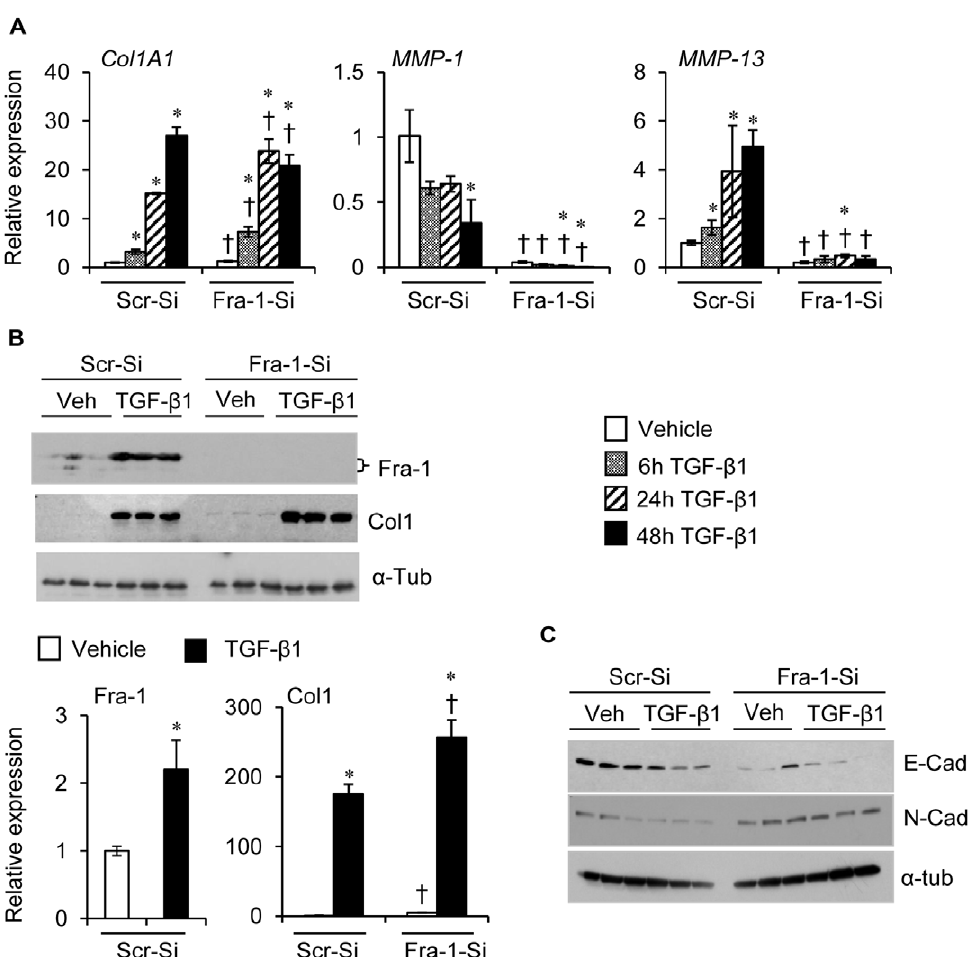
Figure 9. The effects of Fra-1 knockdown on TGF- b 1-induced fibrotic and anti-fibrotic, and mesenchymal marker gene expression in AECs. Cells were treated with vehicle or TGF- b 1 (5 ng/ml) for different time points, and harvested for RNA and protein isolation. A: Col1A1 , MMP-1 and MMP-13 expression analyzed by qRT-PCR. B: Fra-1, Col1 and a -tubulin protein expression as analyzed by immunoblot in AECs cells treated with vehicle or TGF- b 1 for 24 hours. C: E-cad, N-Cad, and a -tubulin detected by immunoblot in AECs treated with vehicle or TGF- b 1 for 24 hours. Results are mean 6 SD, representative of 2 separate experiments performed in triplicate per group. P , 0.05, PBS vs TGF- b 1; { P , 0,05, Scr-si-RNA vs Fra-1- SiRNA cells at corresponding time